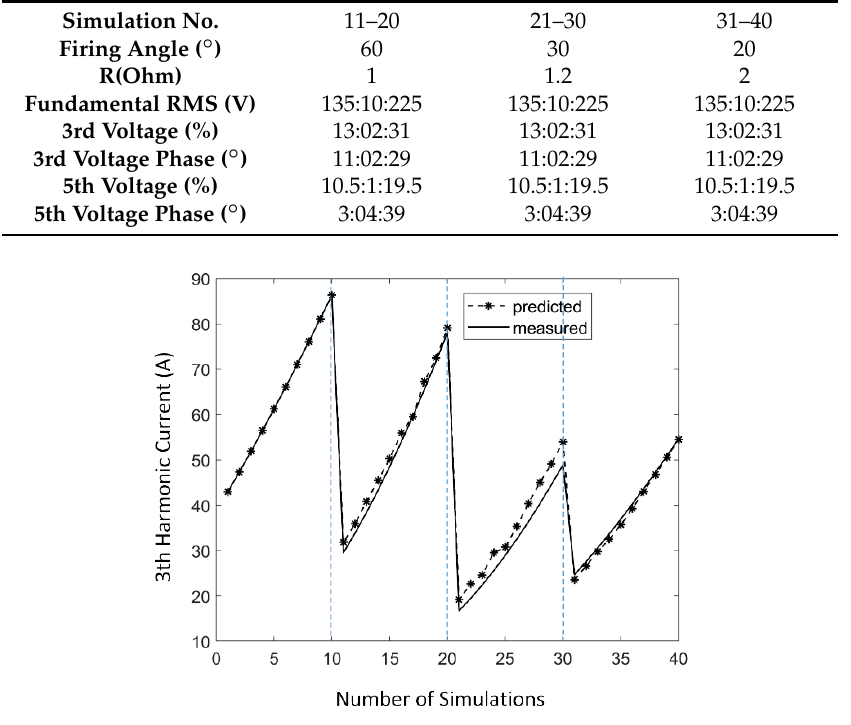
Figure 7. 3th harmonic current estimation by proposed recursive method.